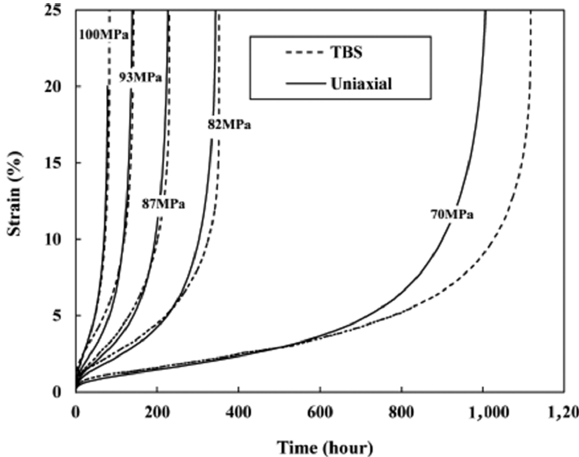
Figure 20: Converted TBS creep strain curves together with the corresponding uniaxial creep strain curves for grade P91 steel at 650 ° C, using 70, 82, 87, 93 and 100